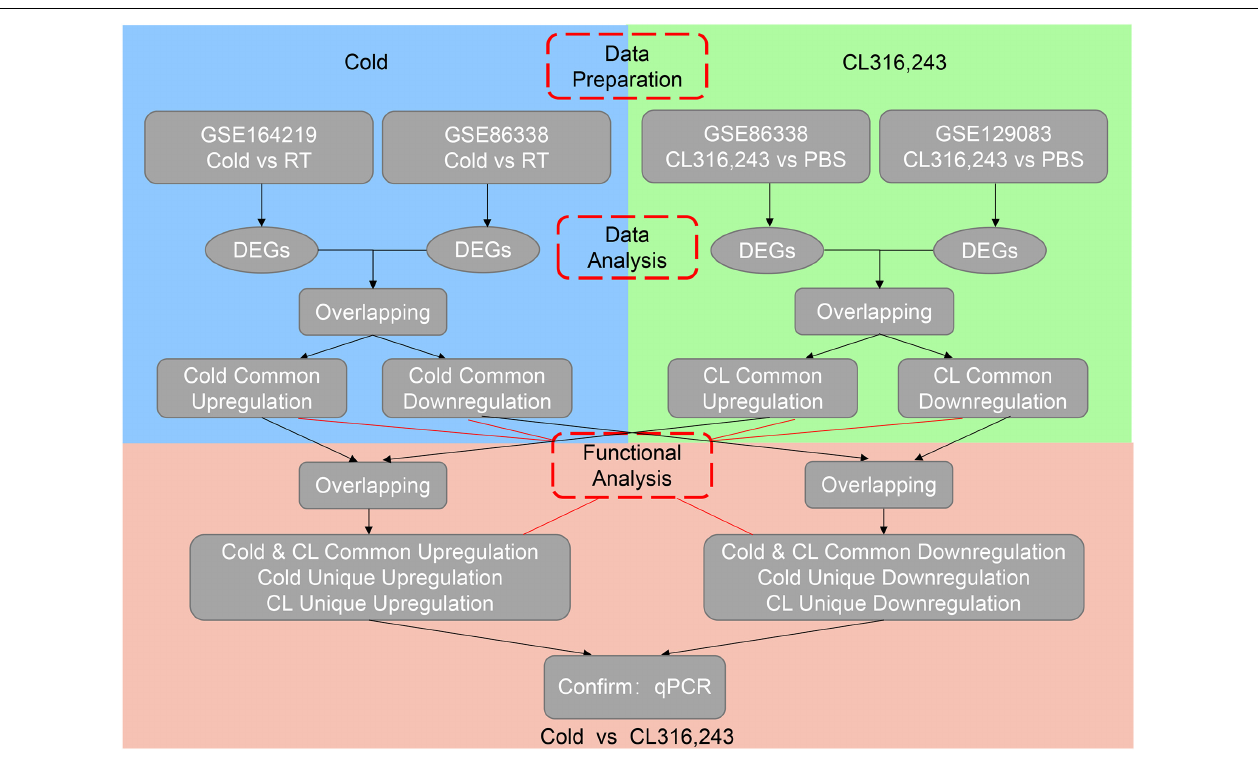
FIGURE 2 | Flow chart of RNA-sequencing data processing.